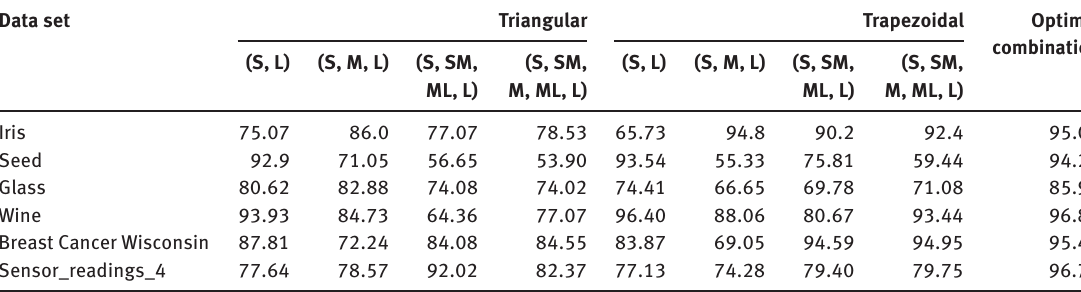
Table 7: Predictive Accuracy with Different Combinations of MFs and Number of Linguistic Terms.